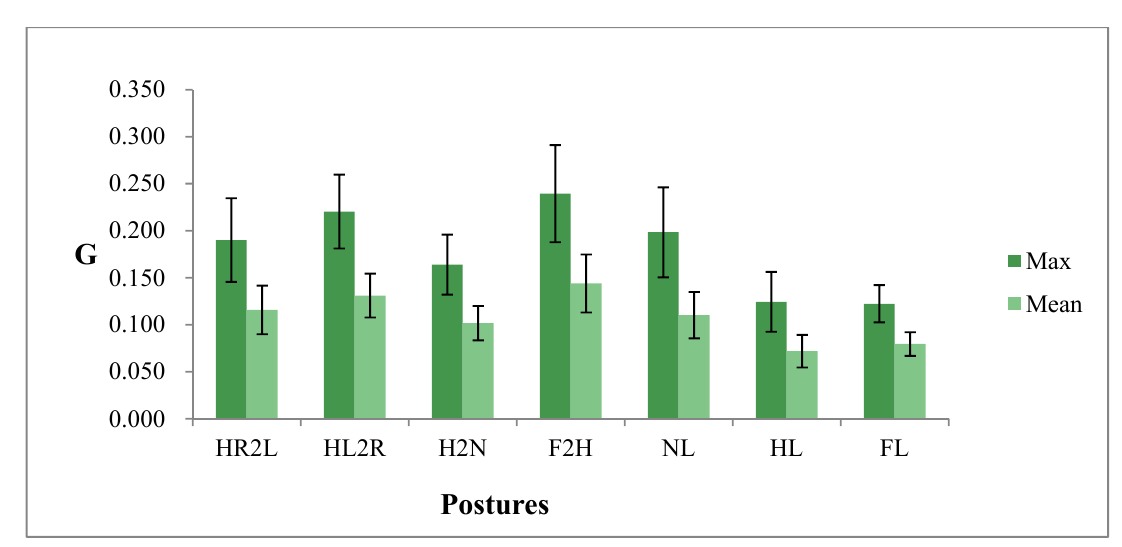
Figure 3. The mean and std motion index for Experiments 1a and